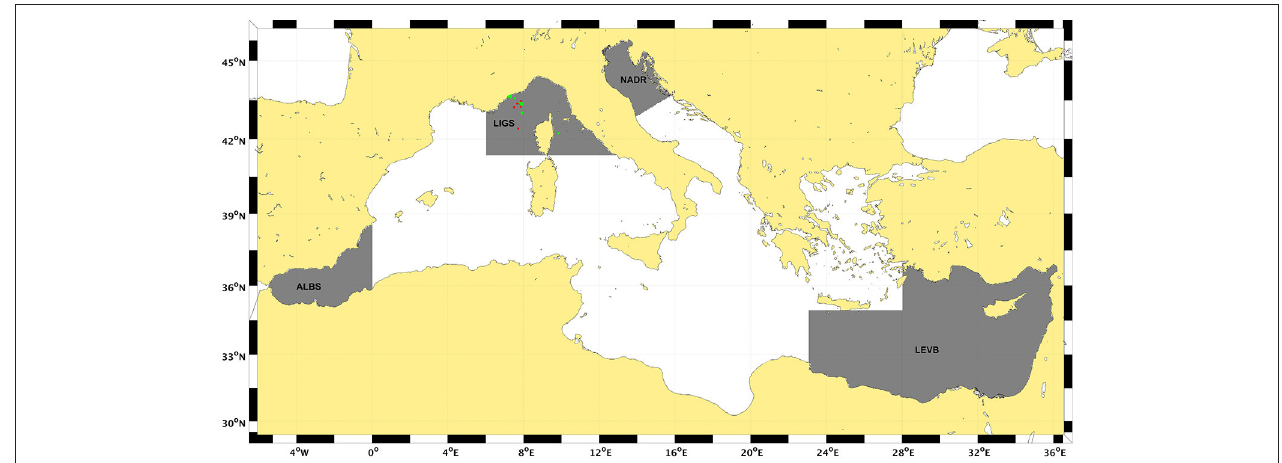
FIGURE 1 | Map of the Mediterranean Sea. Gray areas show the sub-regions selected in this study for a regional assessment: Alboran Sea (ALBS), Ligurian Sea (LIGS), Northern Adriatic Sea (NADS), and Levantine basin